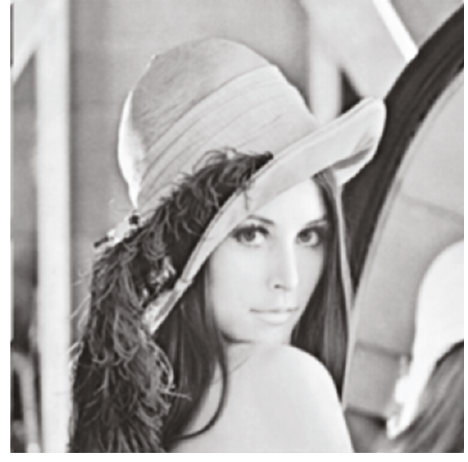
Figure 9: Test images